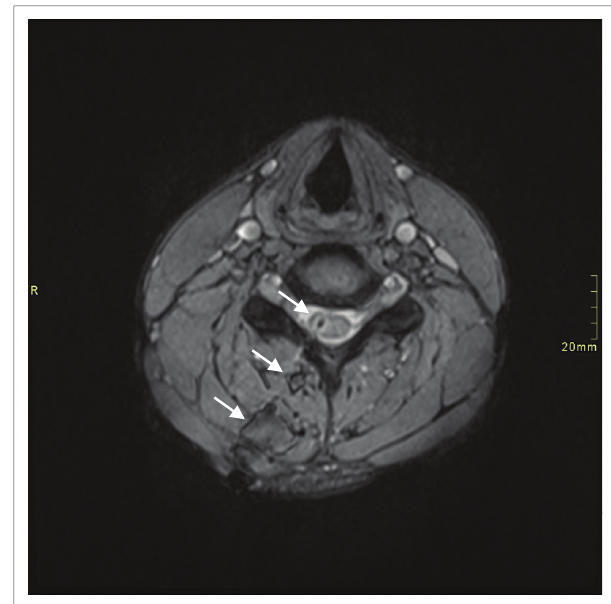
FIGURE 5: Axial gradient recalled echo image demonstrating cord blood and paraspinal muscle blood along the stab wound tract (arrows).